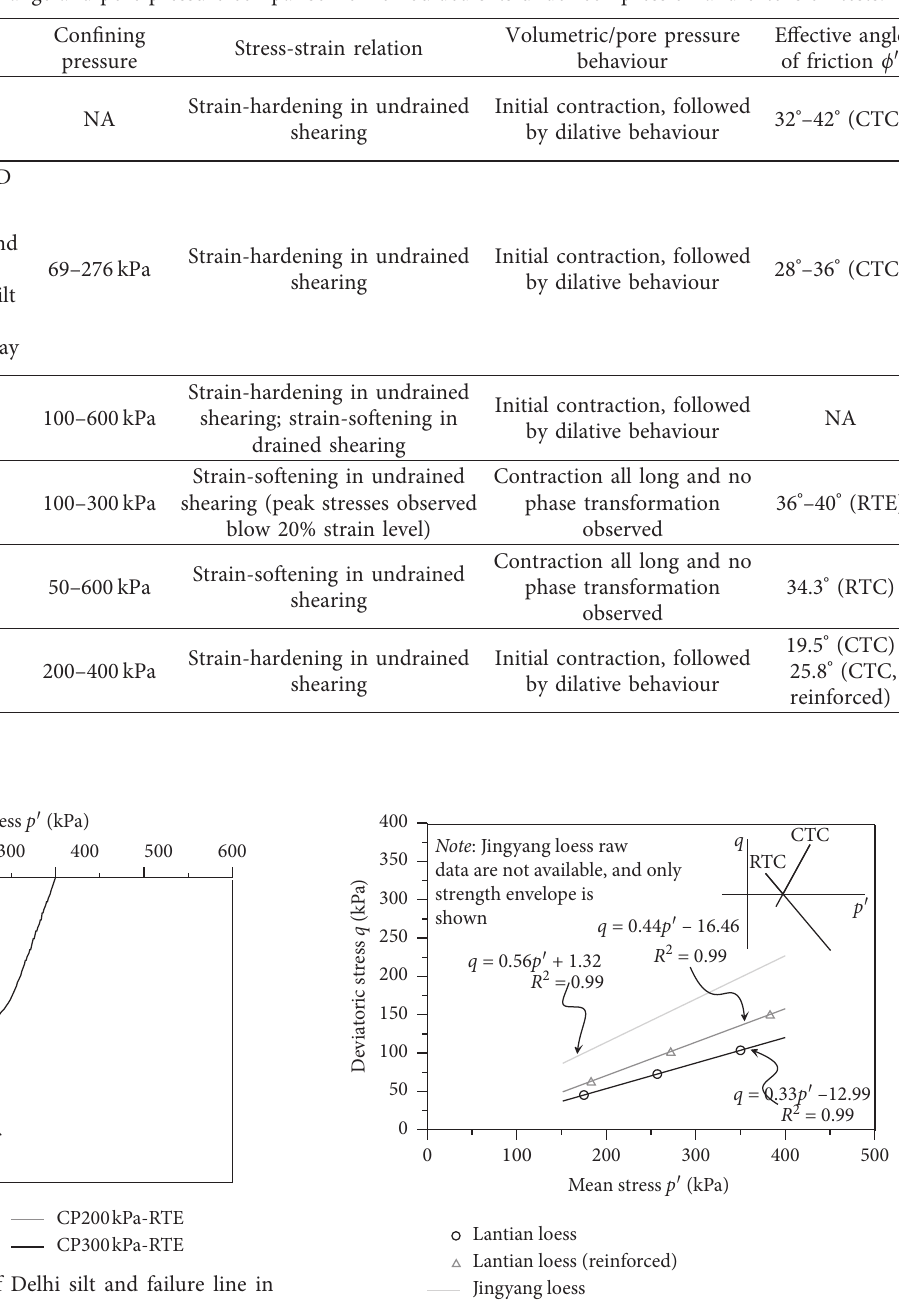
Figure 11: Strength envelopes of Lantian loess and reinforced Lantian loess as well as Jingyang loess in compression